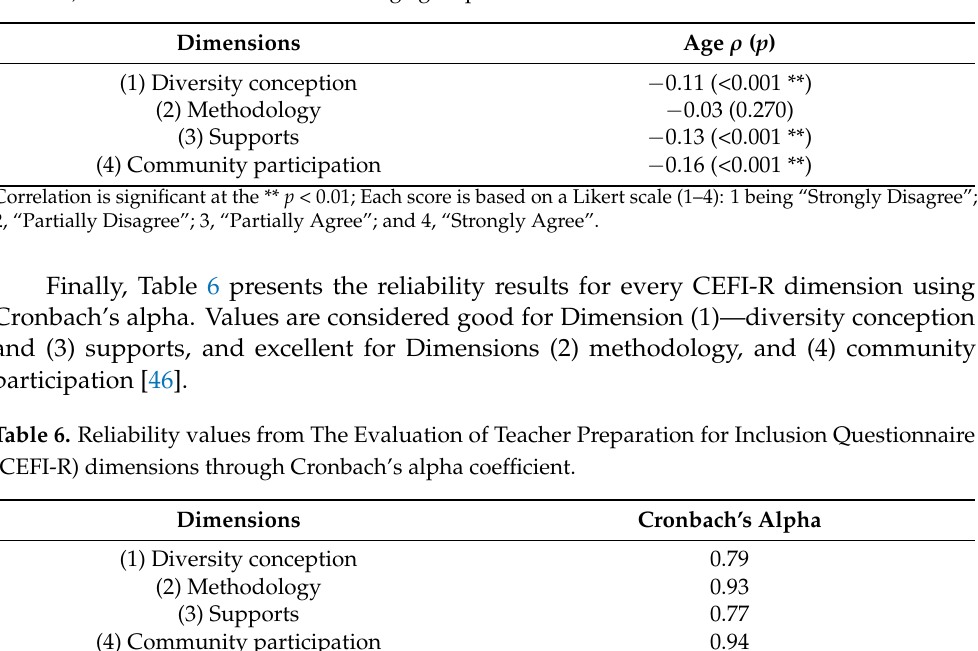
Table 5. Correlations between The Evaluation of Teacher Preparation for Inclusion Questionnaire (CEFI-R) dimensions and the teachers’ age group.